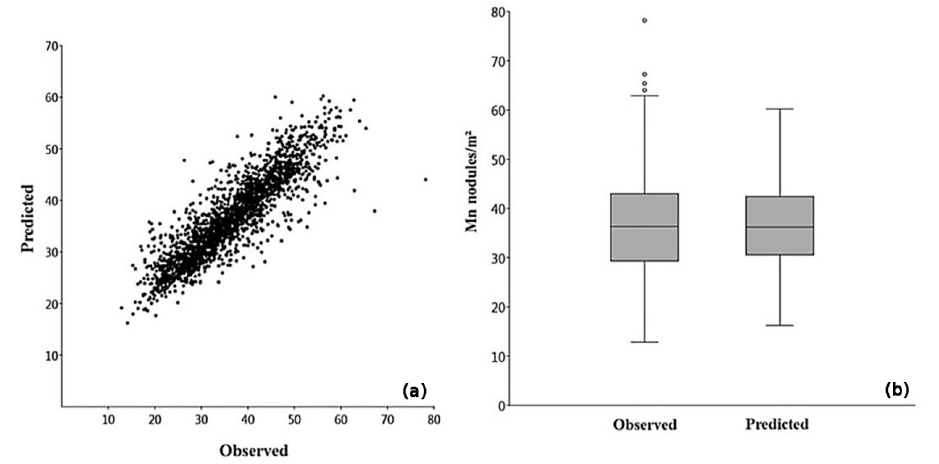
Figure 12. Comparison between observed and predicted values: scatterplot (a) and box plots (b)